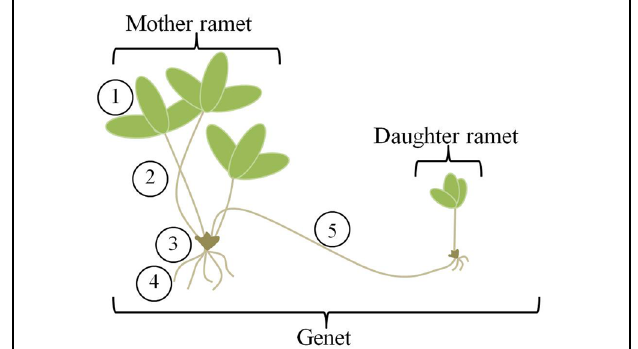
FIGURE 1 | Clone morphology. Strawberry genets are made up of mother and daughter ramets connected by aboveground stolons. Individual mother and daughter ramets consist of five main organs (1) leaves, (2) petioles, (3) crown or stem, (4) roots, and (5) stolons. For analysis, we have combined the petioles and crown, labeling them